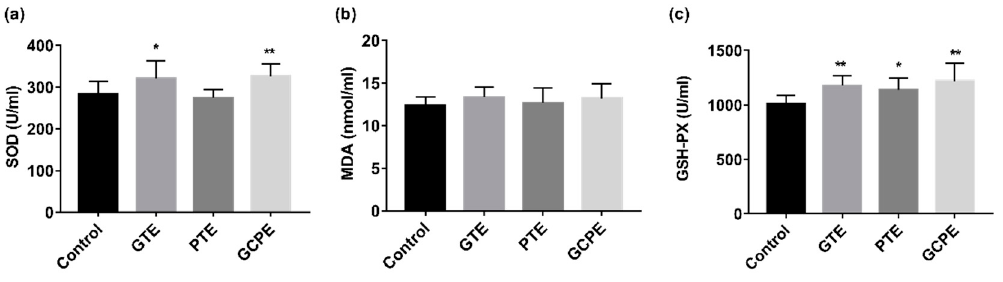
Figure 4. Effects of oral administration of GTE, PTE, and GCPE on the antioxidant functions in rats ( n = 10, compare with the control group * p < 0.05, ** p < 0.01). ( a ) Superoxide dismutase (SOD) in serum; ( b ) malondialdehyde (MDA) content in serum; ( c ) glutathione peroxidase (GSH-PX) in serum.